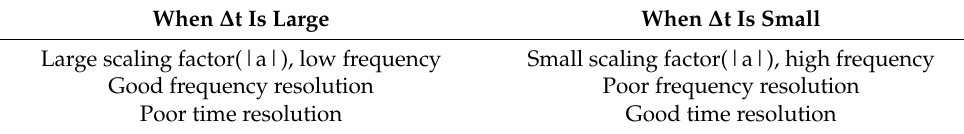
Table 1. The performance of time–frequency resolution under different sizes of Δ t . When Δ t is Large When Δ t is Small Large scaling factor(|a|), low frequency